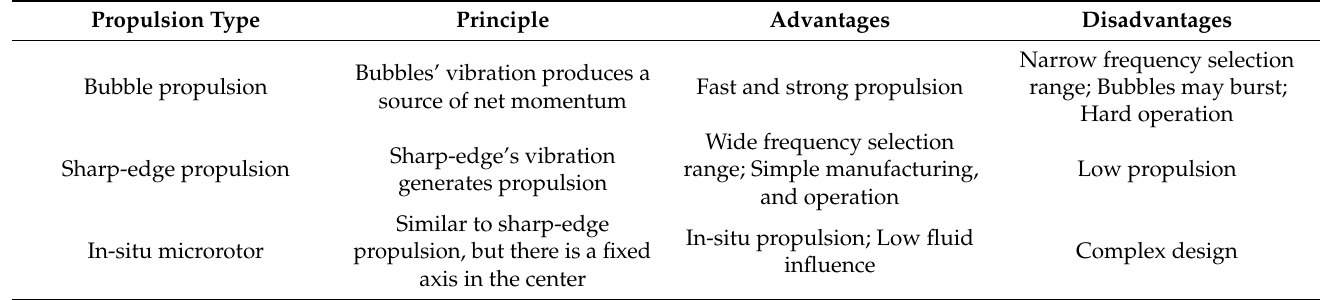
Figure 7. Different structures of in-situ microrotors. ( A ) Acoustic actuation of single in-situ microrotor. ( B ) Acoustic actuation of multiple in-situ microrotors with a microscopic fluorescence image for showing the microstreaming flow lines induced by vibration actuation. Reproduced with permission from Refs. [42,53] respectively. Table 2. The differences among bubble propulsion, sharp-edge propulsion, and in-situ microrotor.